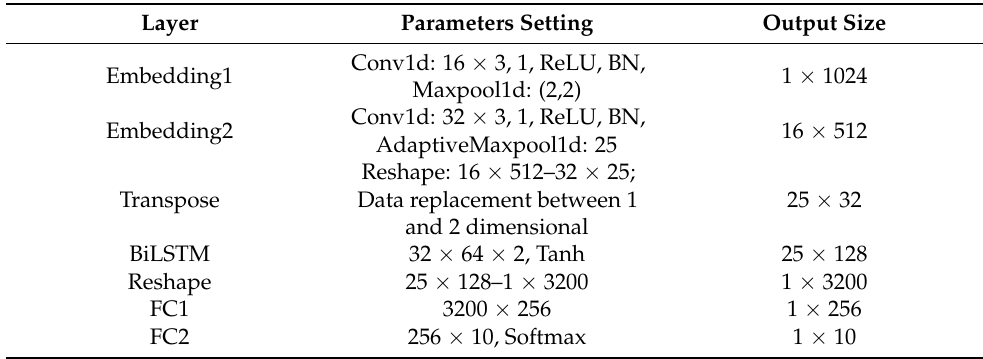
Table 2. The structure of the fault diagnosis